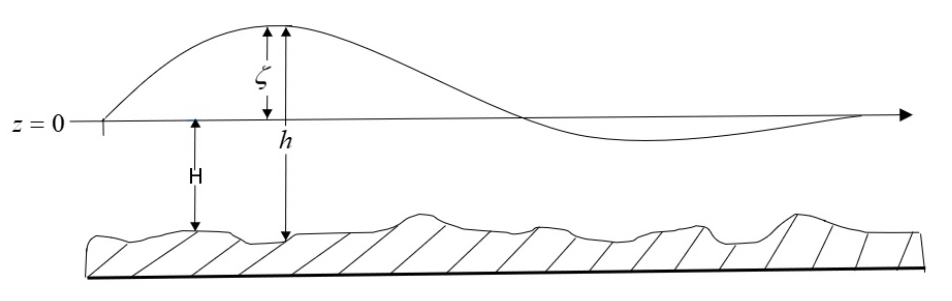
Figure 2. The vertical cross-section of